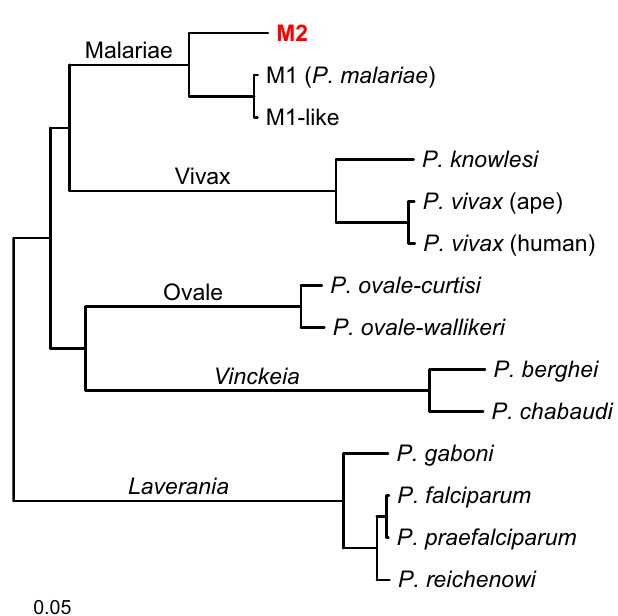
Fig. 3 Relationship of the novel P. malariae -related species M2 to other mammalian Plasmodium species, including M1 (represented by P. malariae ) and its close relative M1-like, from African apes. A maximum-likelihood tree was derived from protein alignments. Nucleotide sequences for 186 genes with one-to-one orthologues in all 14 genomes were translated and aligned, then gene alignments were cleaned and concatenated to a single alignment from which the tree was constructed. The fi ve major lineages are labelled; for the two corresponding to subgenera the names are italicised. The tree has been rooted on the branch to the Laverania 36 . The new, divergent ape-derived lineage M2 appears at the top of the tree in red. Bootstrap support from 1,000 replicates was at least 99% for all nodes except that separating the Malariae and Vivax lineages from the rest of the tree. The scale bar represents 0.05